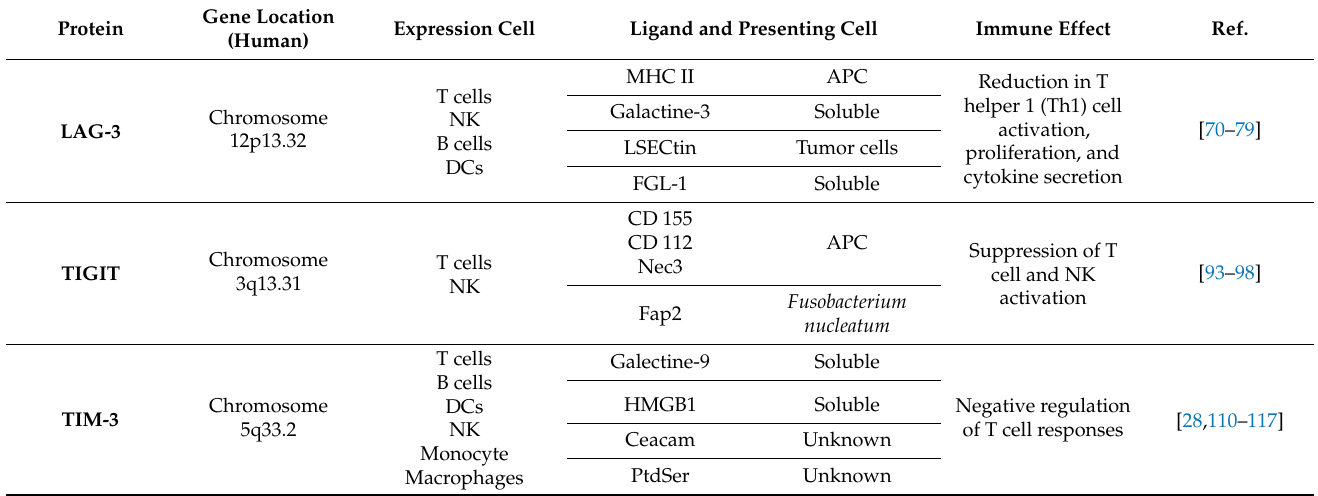
Table 1. Emerging immune checkpoint molecules and their